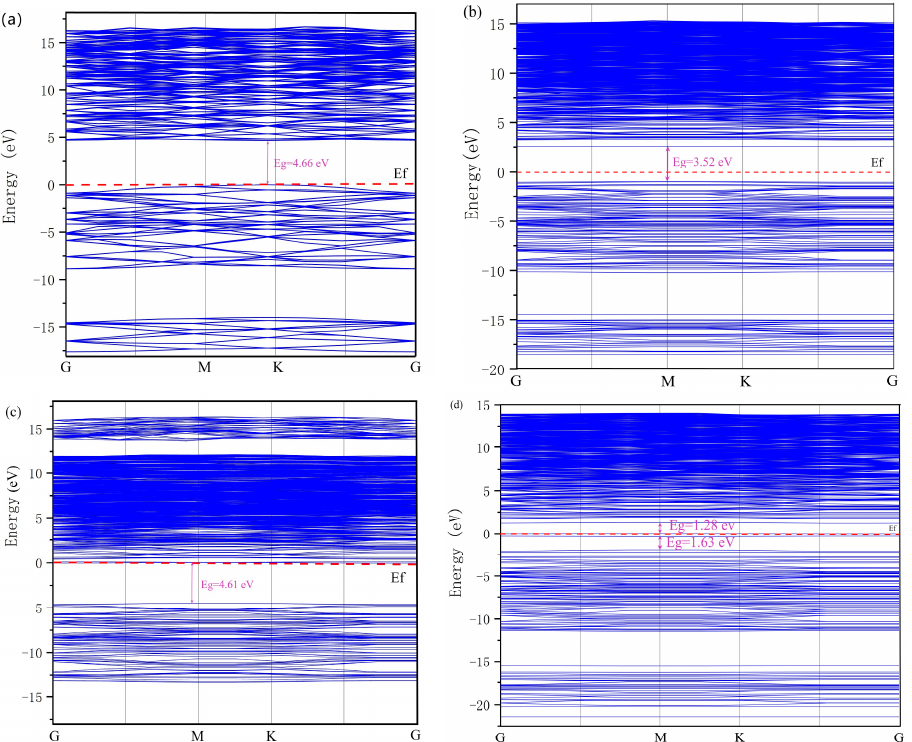
Figure 4. Band structures of ( a ) intrinsic, ( b ) Cs − doped, ( c ) Br − doped, and ( d ) Cs − Br co − doped h-BN.